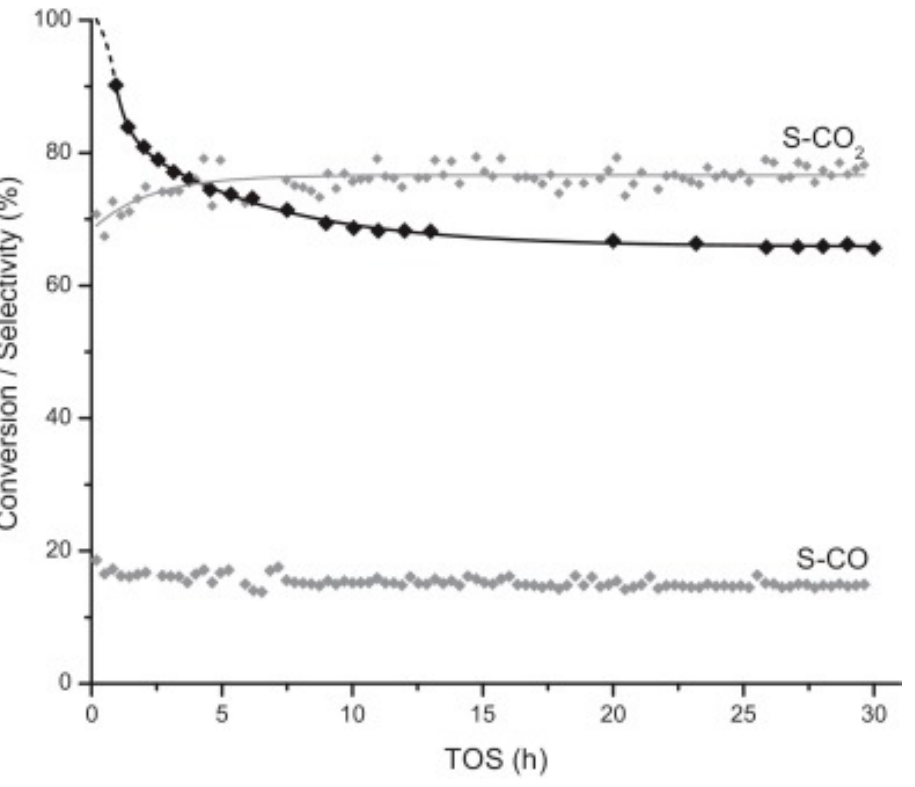
Figure 17. Steam reforming of acetic acid in presence of Ni/HT catalyst with steam to carbon ratio of 5, T = 700 °C, WHSV= 25.2 h − 1 . Reprinted with permission from Ref. [195]. Copyright 2022 Elsevier.